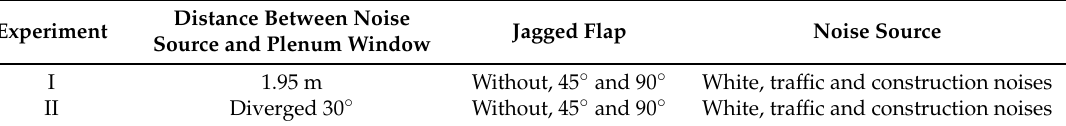
Table 1. All tested conditions.